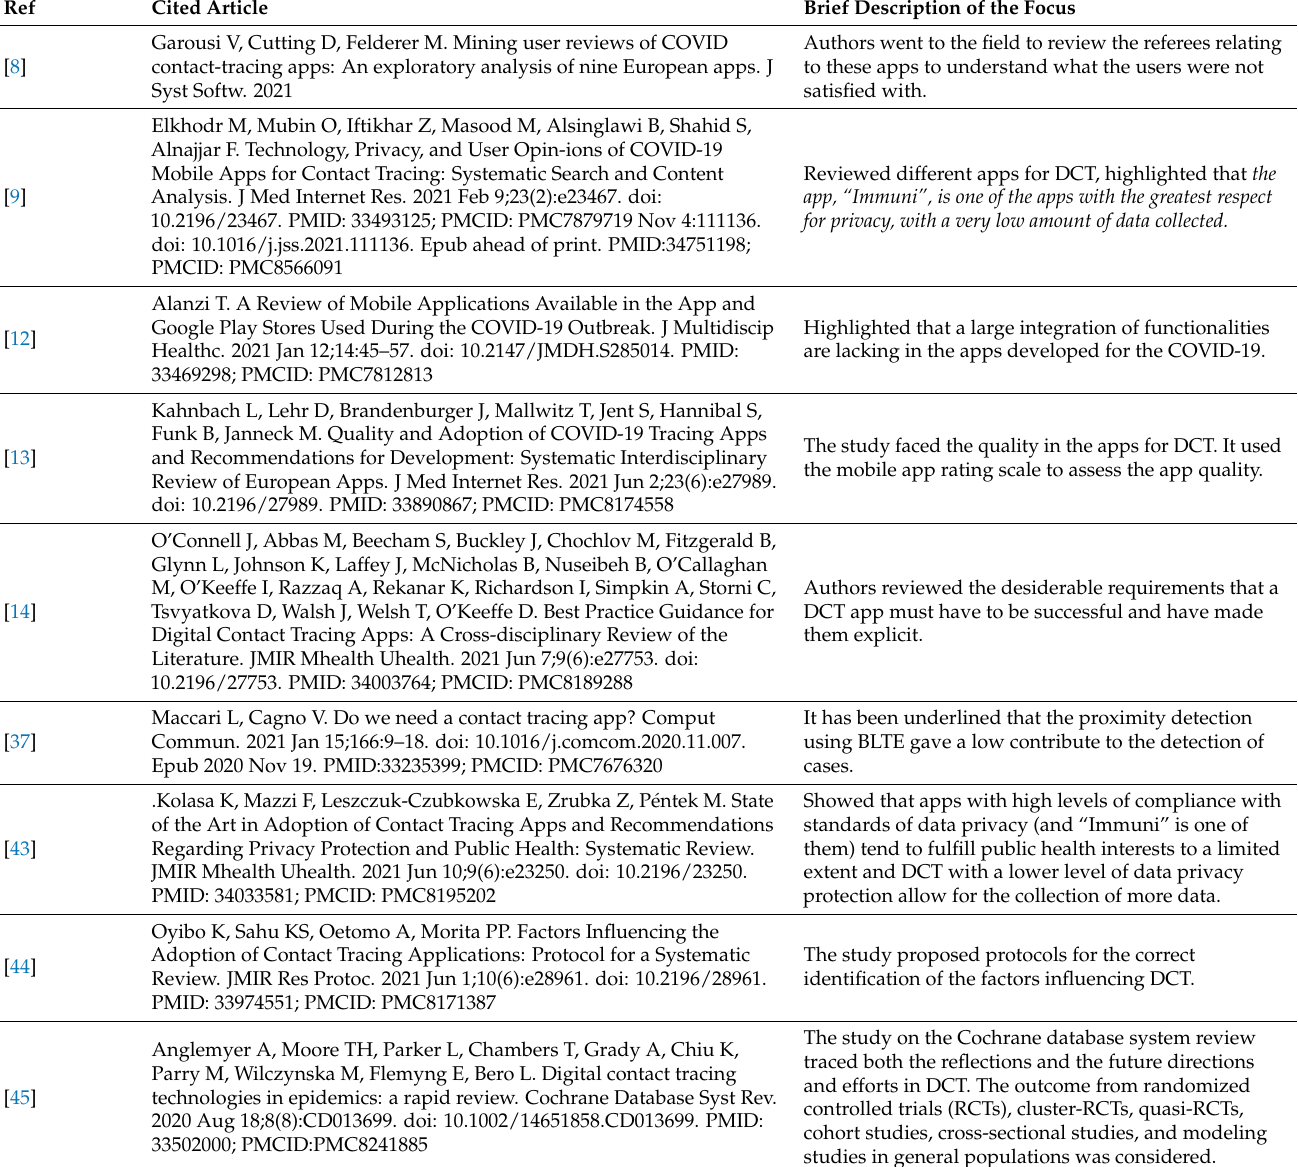
Table 3. Articles on DCT recalled with a brief description of their